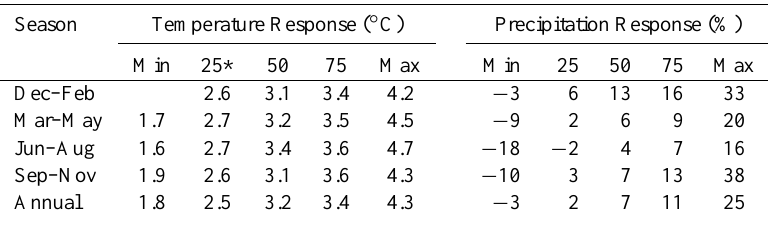
Table 6. Regional averages of temperature and precipitation projections from a set of 21 global models for the A1B scenario for East Africa (12 ◦ S, 22 ◦ E; 18 ◦ N, 52 ◦ E) (IPCC,